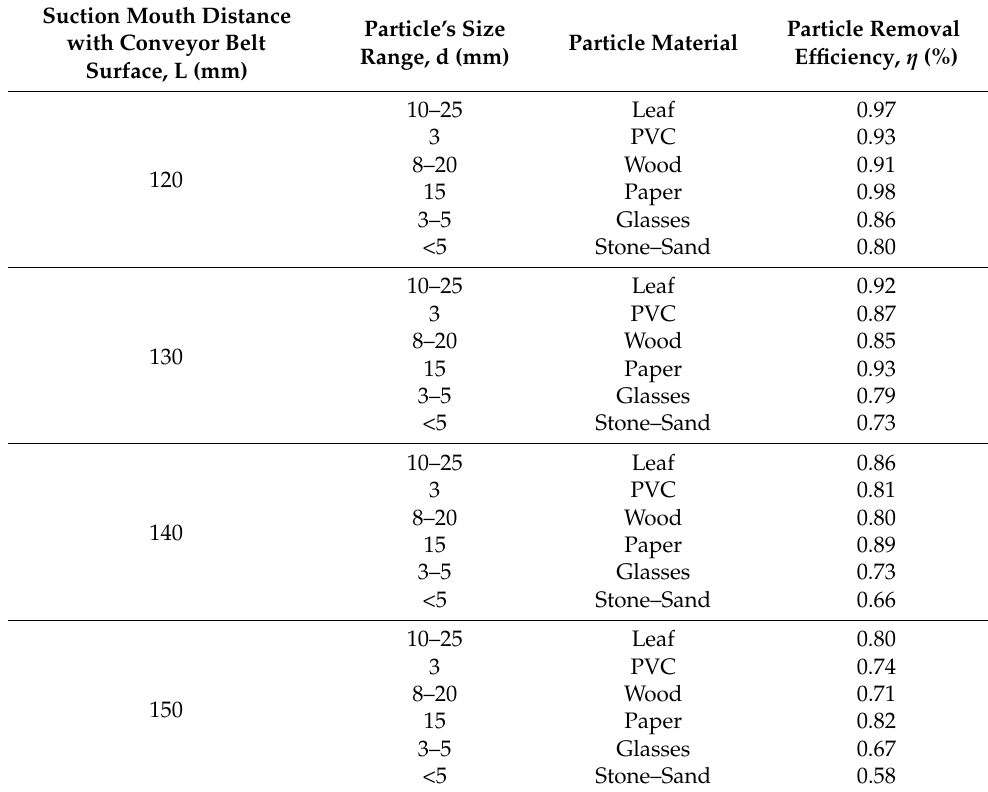
Table 6. The effect of the distance between the road surface and the suction mouth on the efficiency of particle